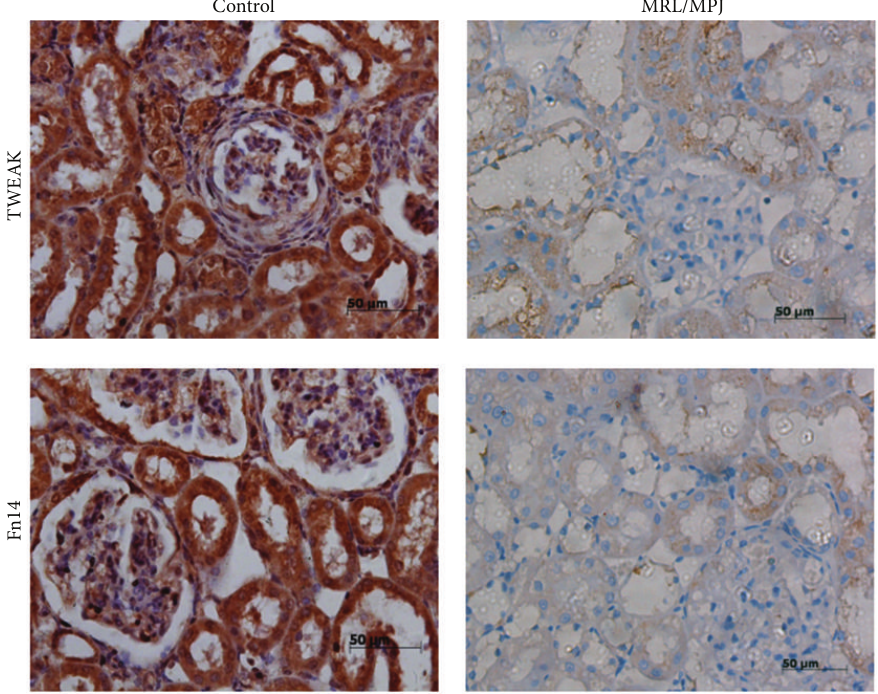
Figure3:DistributionofTWEAKandFn14inkidneysofMRL/Lprmice.Immunohistochemistrystainingofkidneysshowsstrongexpression of TWEAK and Fn14 in the kidneys from MRL/lpr mice, but they were only weakly seen in the kidney of MRL/MPJ mice. Control: MRL/lpr mice treated with PBS and MRL/MPJ: MRL/MPJ mice as normal control. Scale bar: 50 𝜇 m.